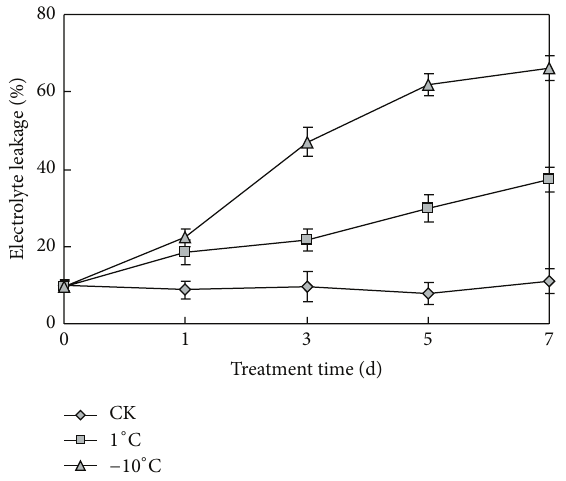
Figure 2: Relative electrolyte leakage of seedling leaves under nor- mal and low temperatures. CK represents normal growth condition. Each value is the average ± standard error ( ± SE) result of three independent measurements.